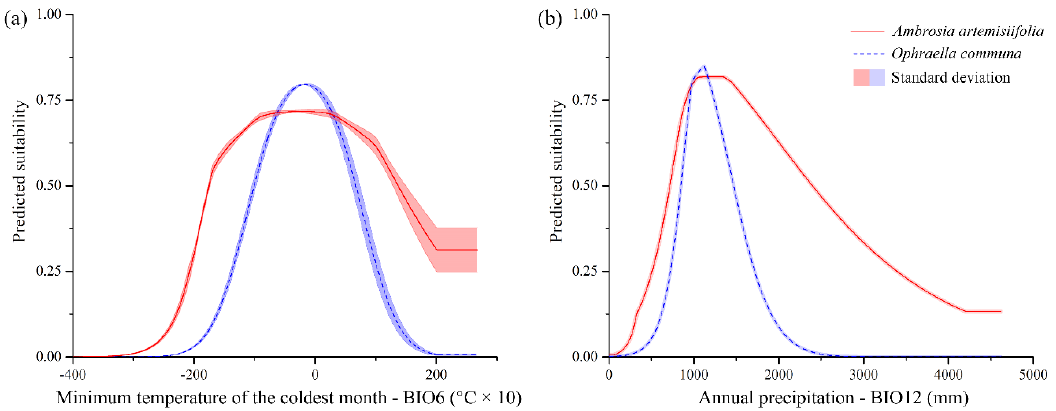
Figure 1. Shared variables’ response curves for Ambrosia artemisiifolia and Ophraella communa . Marginal response curves obtained for the two variables BIO6 (minimum temperature of the coldest month) ( a ) and BIO12 (annual precipitation) ( b ), which were among the three most contributive predictors for both Ambrosia artemisiifolia and Ophraella communa .